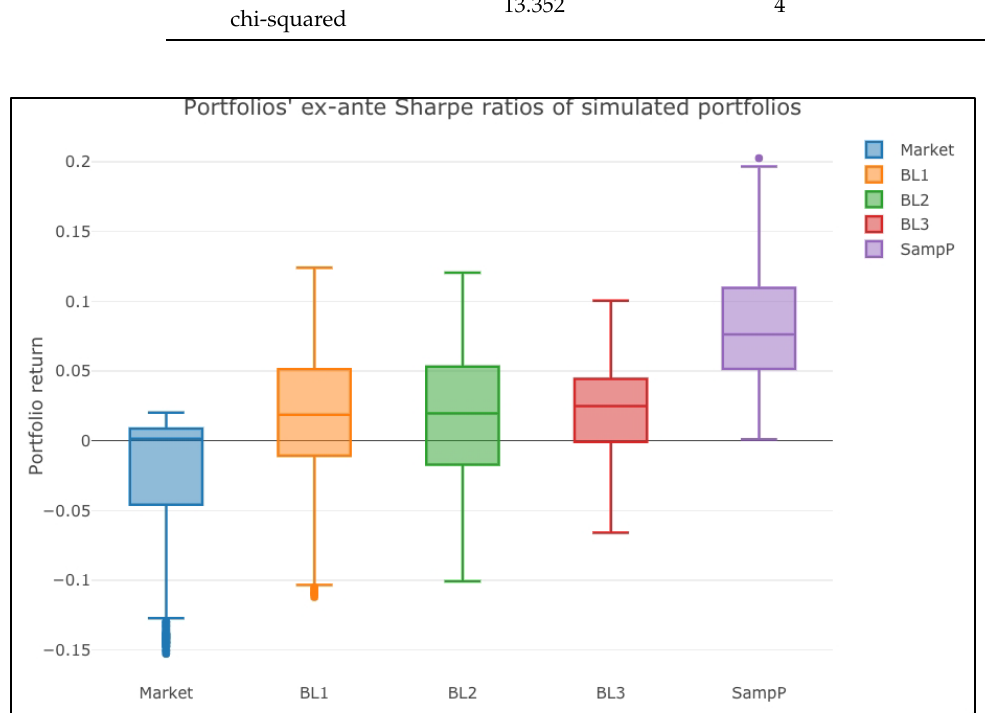
Figure 6. Simulated portfolios’ ex-ante Sharpe ratio boxplot.